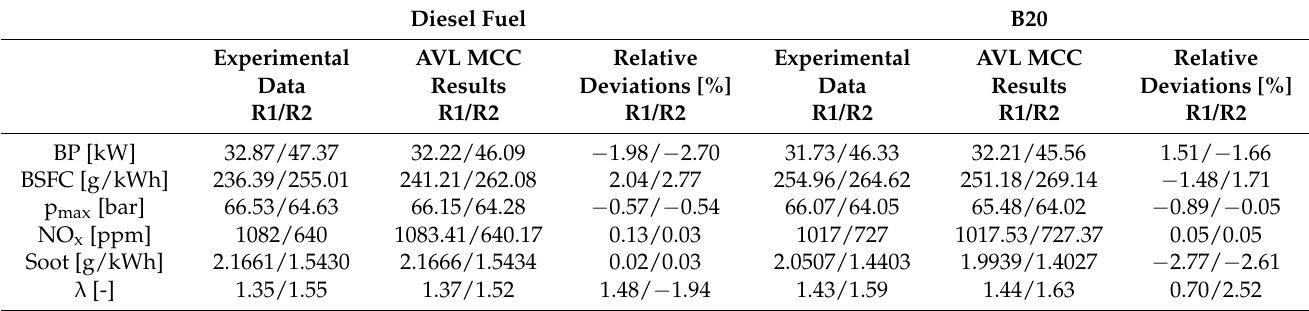
Table 5. The calibration of the simulation